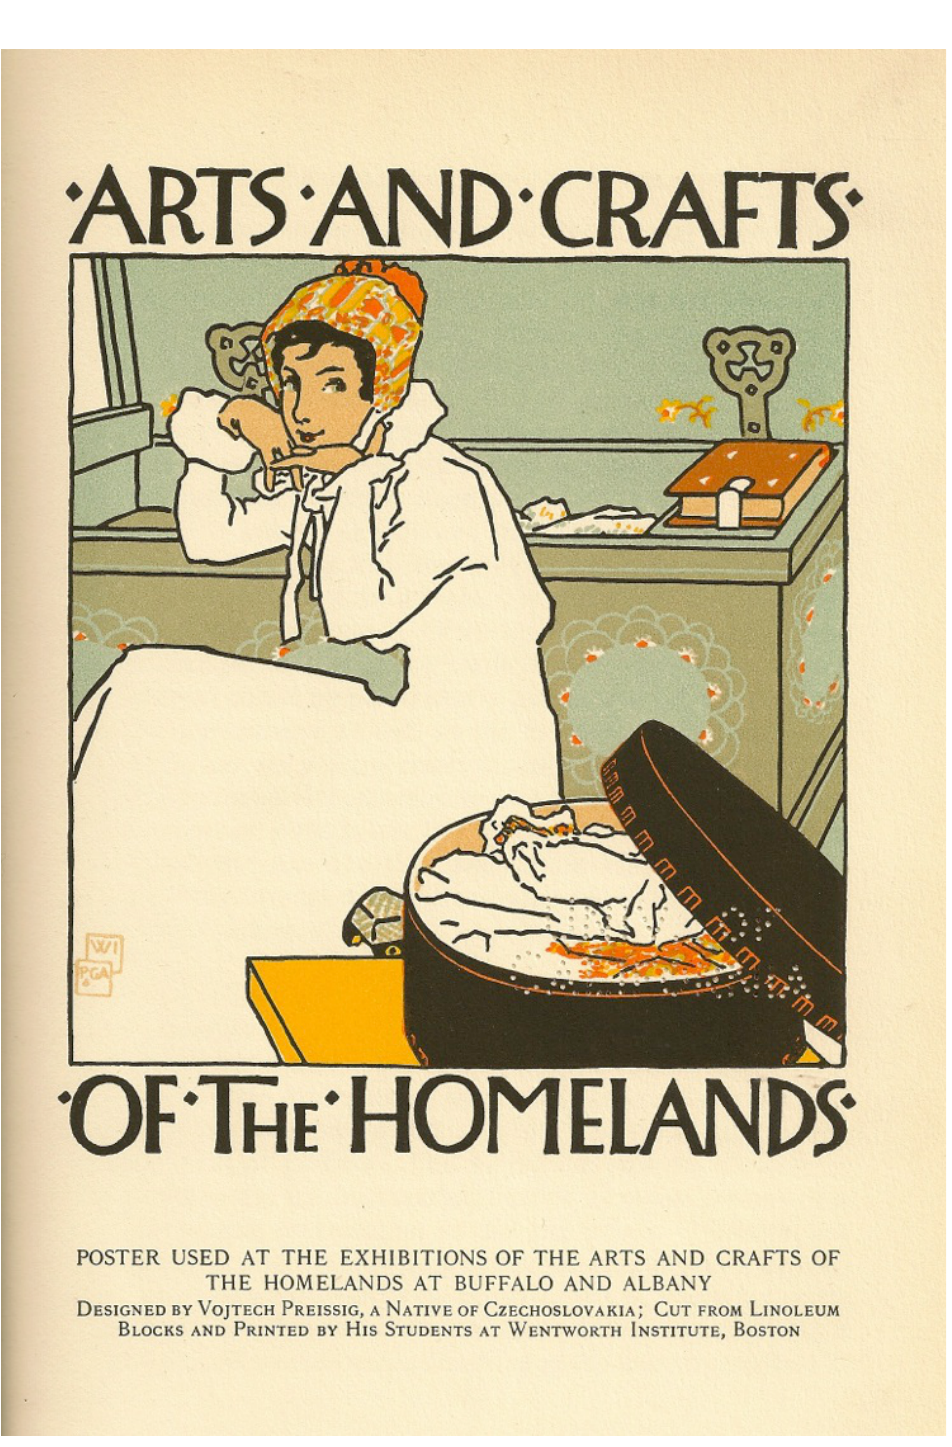
Figure 7 Vojtech Pressig, “Poster Used at the Exhibitions of the Arts and Crafts of the Homelands ” , image from page 60 of Allen H. Eaton, Immigrant Gifts to American Life. © 1932 Russell Sage Foundation, 112 East 64 th Street, New York, NY 10065. Reprinted with Permission. Reprinting, reposting, or republishing is prohibited without written consent from the Russell Sage